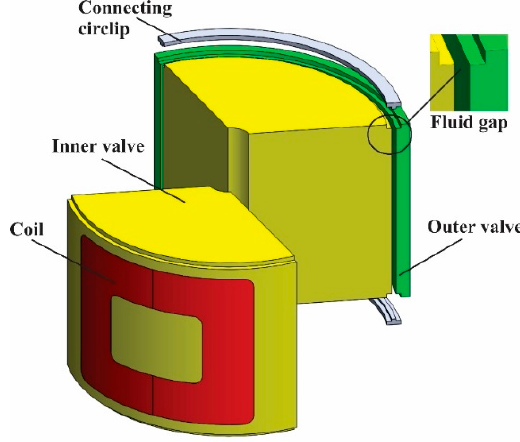
Figure 4. Static valve design configuration. Table 2. TVMRB component materials.